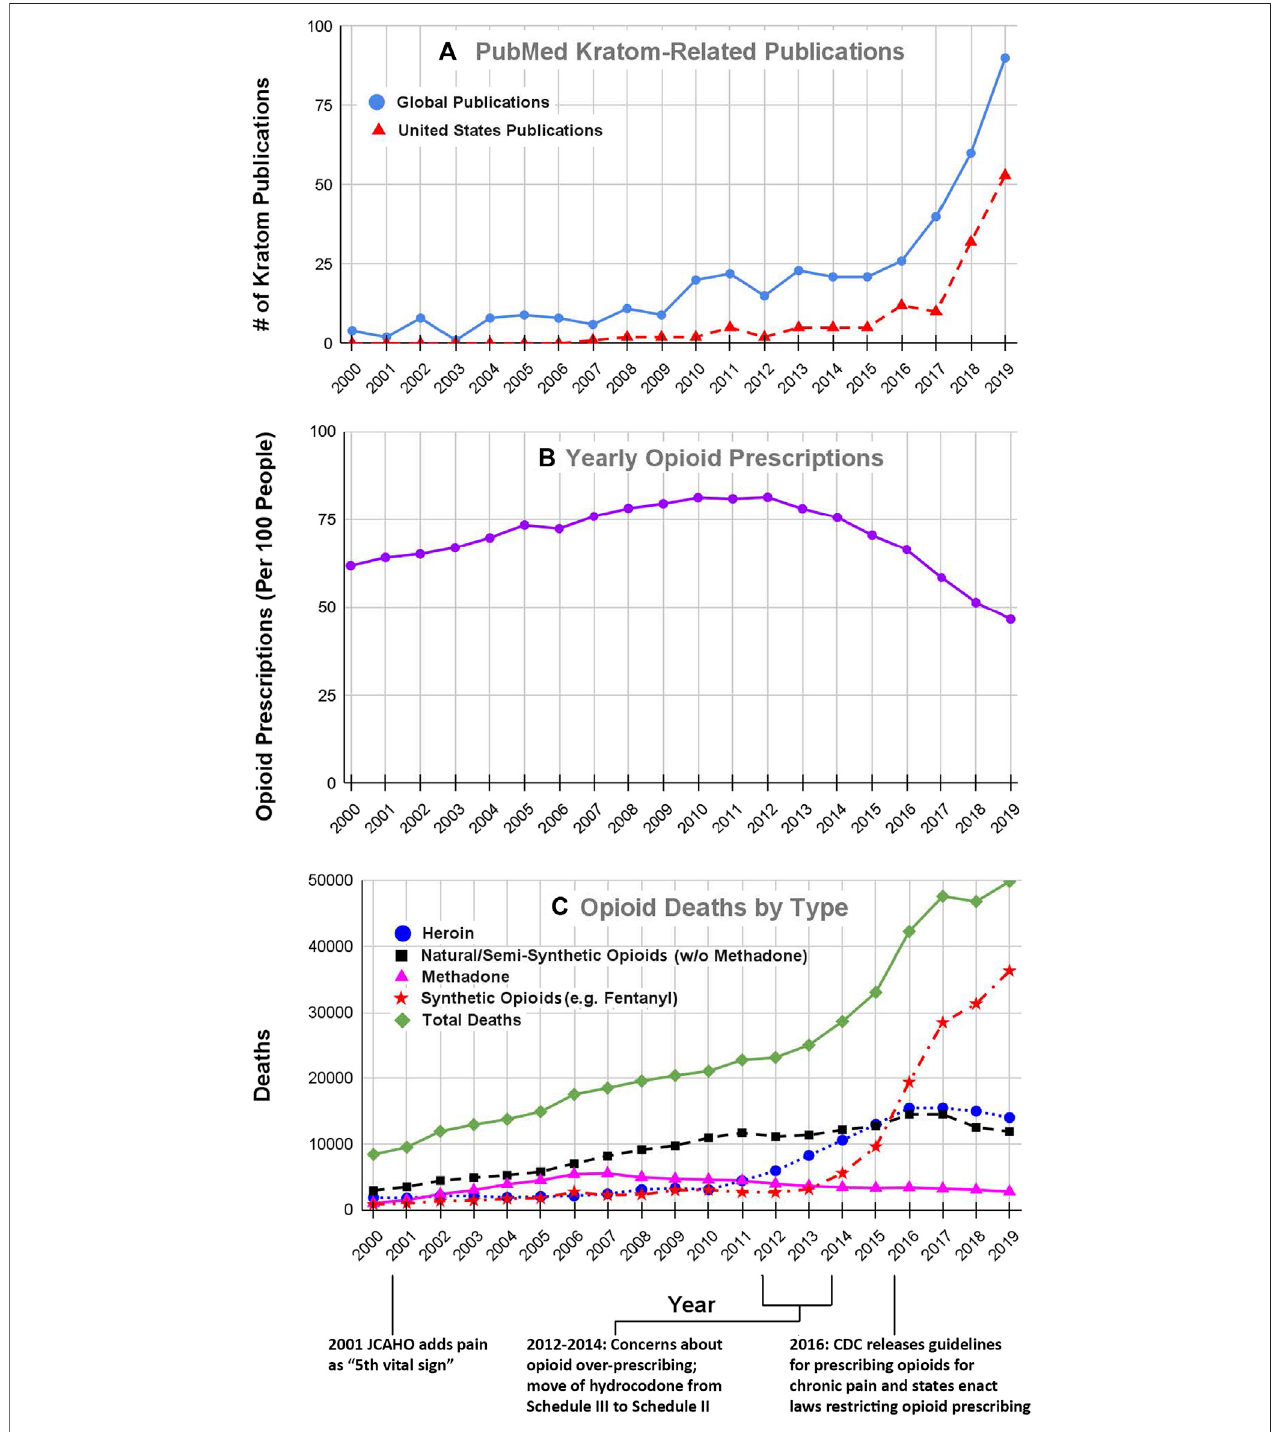
FIGURE 1| Kratom-related publications (A) , opioid prescribing rates (B) and number of opioid overdosedeaths (C) for years 2000 – 2019. The number of Kratom- related publications ( Figure 1A ) was obtained from a search of the United States National Library of Medicine ’ s PubMed database, using the search term “ kratom ” on april 26, 2021. The solid black line shows the total number of publications for each year, whereas the broken line shows the number of publications in which at least one author was based in the United States. The data for opioid prescribing rates for the years 2000 – 2006 were obtained from (Kenan et al., 2012); data for the years 2006 – 2019 were obtained from the CDC database at https://www.cdc.gov/drugoverdose/maps/rxrate-maps.html. Each point represents the number of prescriptions per 100 people for each year. Please note that only 10 – 20% of people received any prescriptions which indicates that people received multiple prescriptions within the same year. Data for the number of opioid-related overdose deaths by drug type were obtained from both the CDC and NIDA data bases at https://www.cdc.gov/nchs/ data/databriefs/db394-tables-508.pdf#page (cid:1) 3 and http://www.drugabuse.gov/drug-topics/trends-statistics/overdose-death-rates. All of these databases are in the public domain. The data that were extracted and used for these analyses are included as a supplemental table.